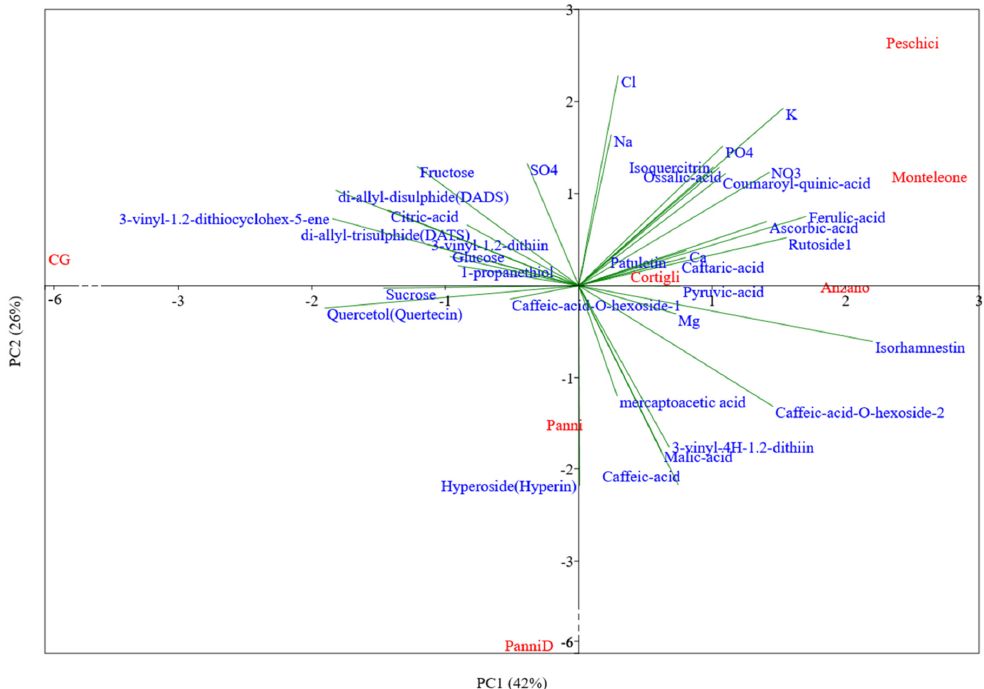
Figure 2. Principal component analysis bi-plot (PC1 vs. PC2) showing the spatial distribution of the main chemical traits as affected by genotypes. Refer to Table 1 for the acronyms of garlic genotypes.